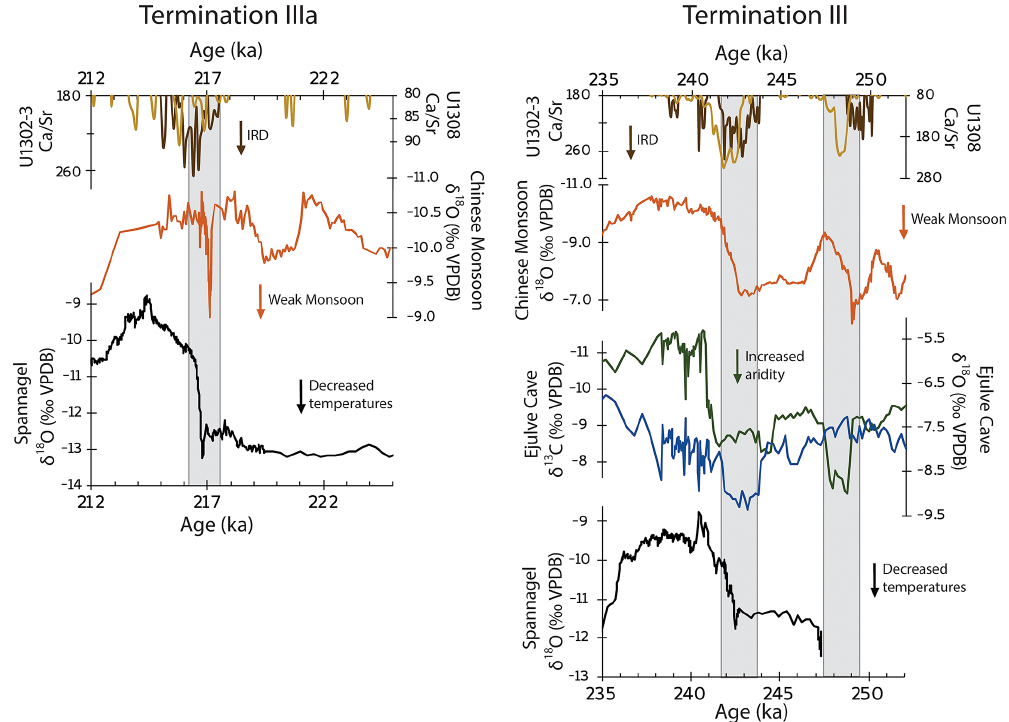
Figure 4. Millennial-scale events leading up to glacial terminations III and IIIa. Ca / Sr ratios (a proxy for IRD) from North Atlantic sediment cores U1308 (brown; Channell et al., 2012) and U1302 and U1303 (yellow; Hodell et al. 2008), Chinese stalagmite δ 18 O (orange; Cheng et al., 2016), Ejulve cave δ 18 O (blue) and δ 13 C (green) from southeastern Spain (Pérez-Mejías et al., 2017), and Spannagel Cave δ 18 O from the Austrian Alps (black; this study). Major IRD events highlighted in